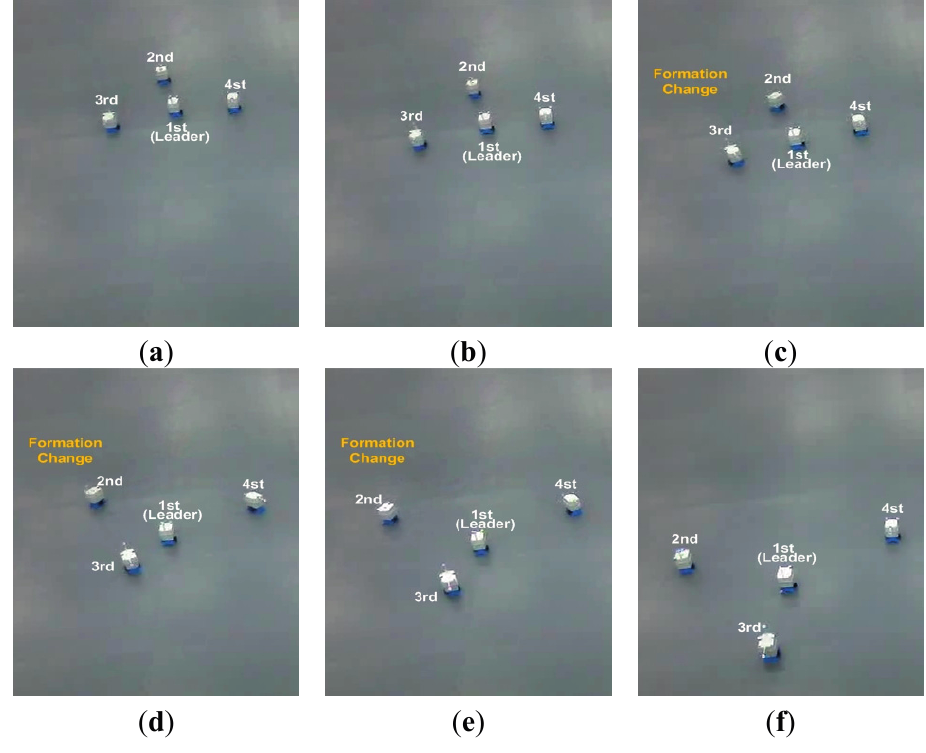
Figure 18. The snapshots of the situation of the formation change.